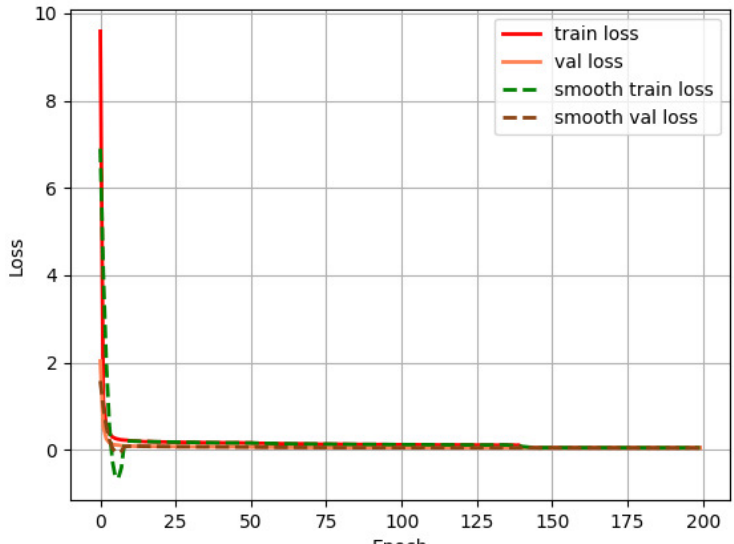
Figure 7. Loss value curve.